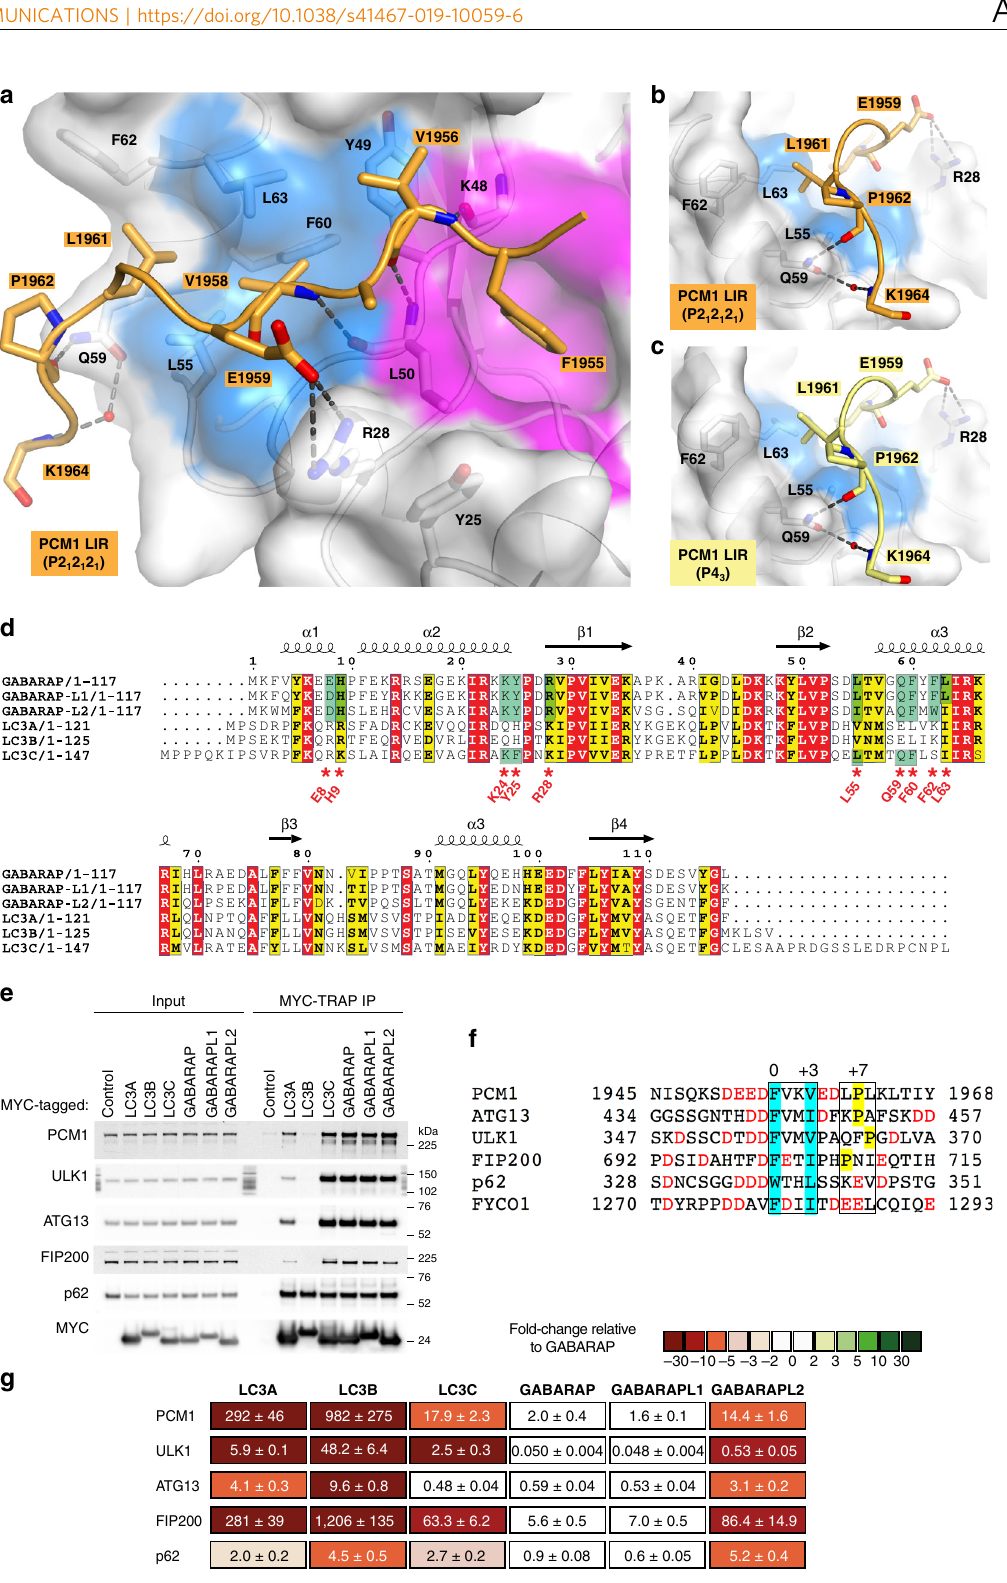
and FIP200 LIRs bound weakly to GABARAP/GABARAP-L1 with K d s of 2.0/1.6 and 5.6/7.0 µM, respectively. The LIR motif of the autophagy receptor p62 (SQSTM1) bound strongly to all six ATG8 proteins. The p62 LIR af fi nity to LC3B (4.5 µM) is similar to the af fi nity (3.2 µM) determined by isothermal calorimetry using a C terminally extended p62 LIR peptide 29 . p62 binding to